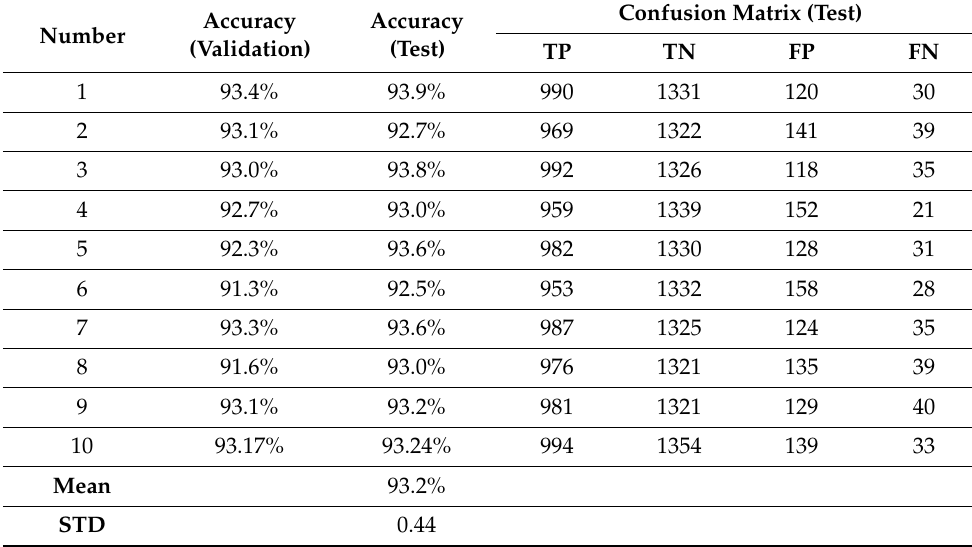
Table 5. Results of the SVM classifier for different runs for 90% PCA variance.